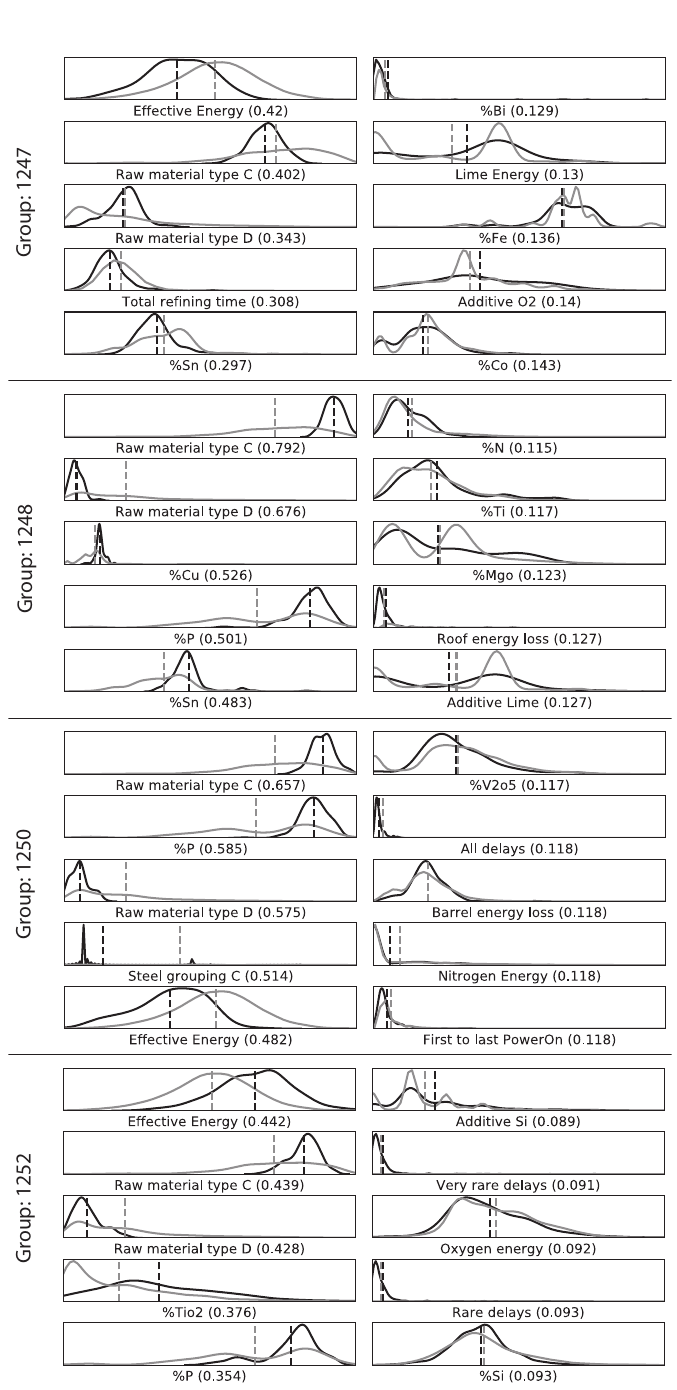
Figure 10. Distribution plots for the 5 variables with the highest ( left ) and lowest ( right ) KS-values, respectively. Truncated distributions (values within the 1000-quantiles) for the group (black) and the rest (gray) are shown. The dashed lines indicate the means of respective distribution. The values in parenthesis show the KS-values. Number of data points and ∆ E El for each group; group 1247: 165, 2160 kWh/heat. Group 1248: 202, − 2740 kWh/heat. Group 1250: 213, 2350kWh/heat. Group 1252: 355, − 2970